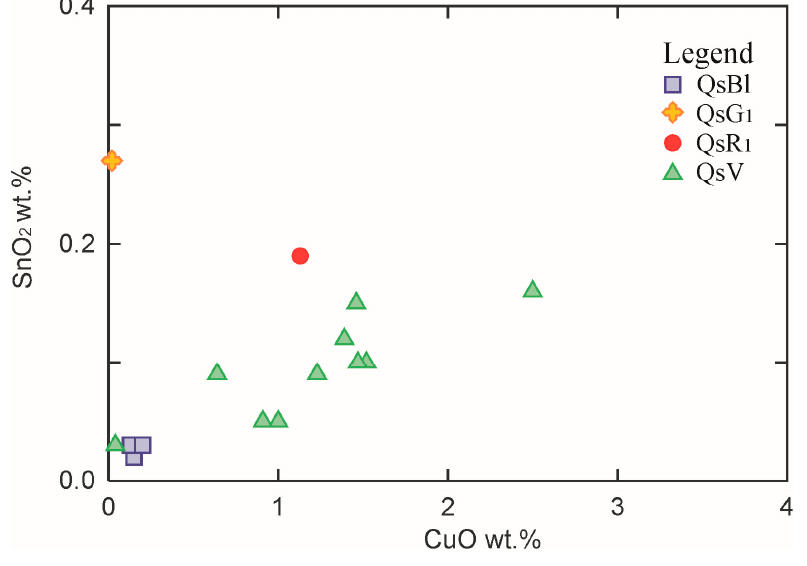
Figure 7. Binary diagram CuO vs. Sn 2 O.